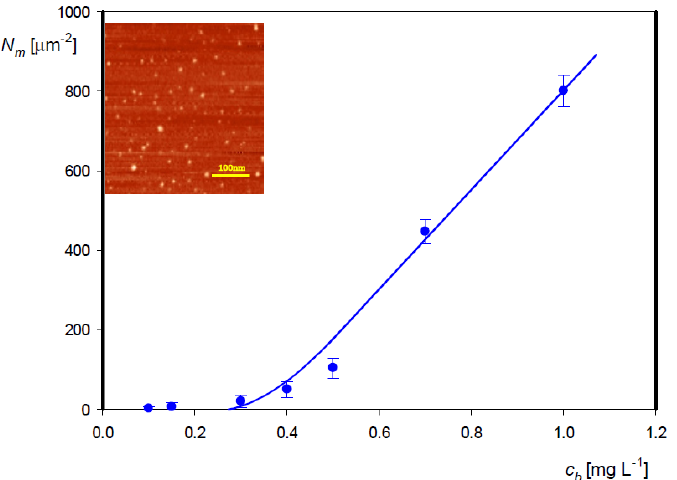
Figure 5. Dependence of the surface concentration of residual myoglobin molecules adsorbed on mica N m on the initial myoglobin concentration c b in the suspension for 0.01 M, NaCl, pH 3.5. The points denote experimental data obtained from AFM measurements and the solid line shows is a non-linear fit of experimental data. The inset shows the myoglobin layer at mica imaged by AFM. The stability of the polymer particles with adsorbed coronas was determined measur- ing their diffusion coefficient and electrophoretic mobility as a function of storage time. These primary data were converted to the hydrodynamic diameter and the zeta potential, respectively and shown in Figure 6 as the dependence of the normalized zeta potential and the normalized hydrodynamic diameter on the storage time. As can be seen, the particles bearing the corona characterized by the coverage of 0.87 mg m − 2 were stable over the time up to 500 min, which suggests that they are prone to long-lasting electrokinetic investi- requires a myoglobin concentration of 0.3 mg L − 1 , whereas in the bulk LDV measurement at least two orders of magnitude larger bulk concentrations are needed.